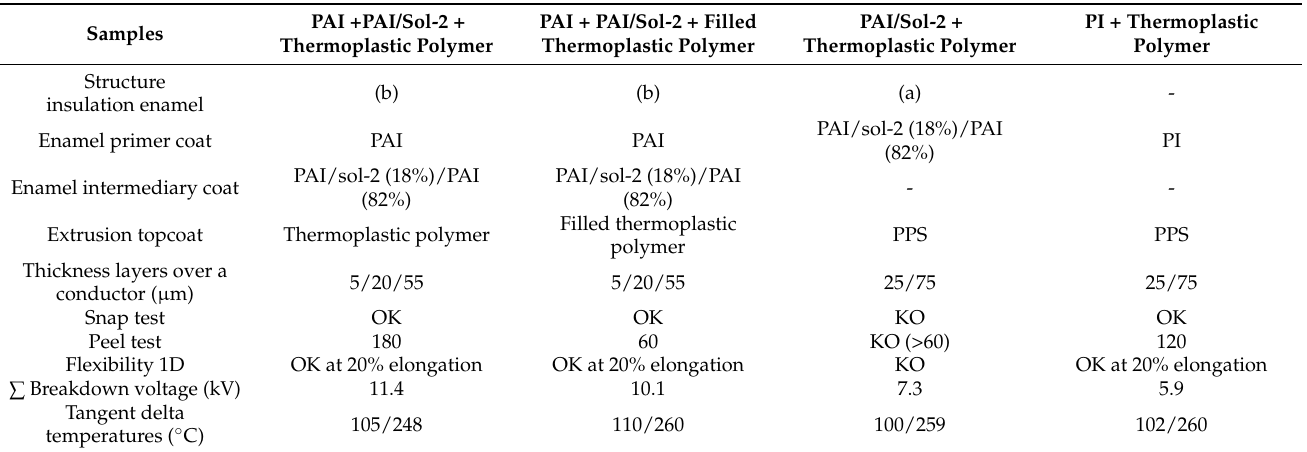
Table 4. Basics characterizations of polymers with a varnish produced by a sol-gel process on the enameled layer with a thermoplastic polymer extrusion layer.